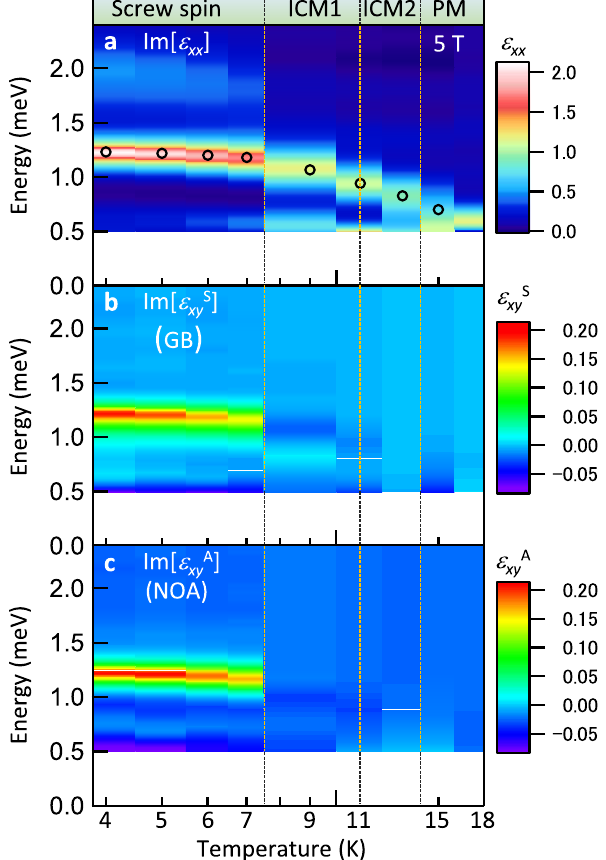
Fig. 3 Correlation of optical activities with spin orders. Color-coded spectra of a electromagnon (Im[ ε xx ]), b GB (Im[ ε S xy ]), and c NOA (Im[ ε A xy ]) in the magnetic fi eld (5 T, H dc ||[110]). The open circles in a indicate the data acquisition temperatures. The GB and NOA emerge in the screw spin phase, manifesting that the ferroelectric and chiral screw spin order gives rise to the GB and NOA. (See Supplementary Note 3 for details of